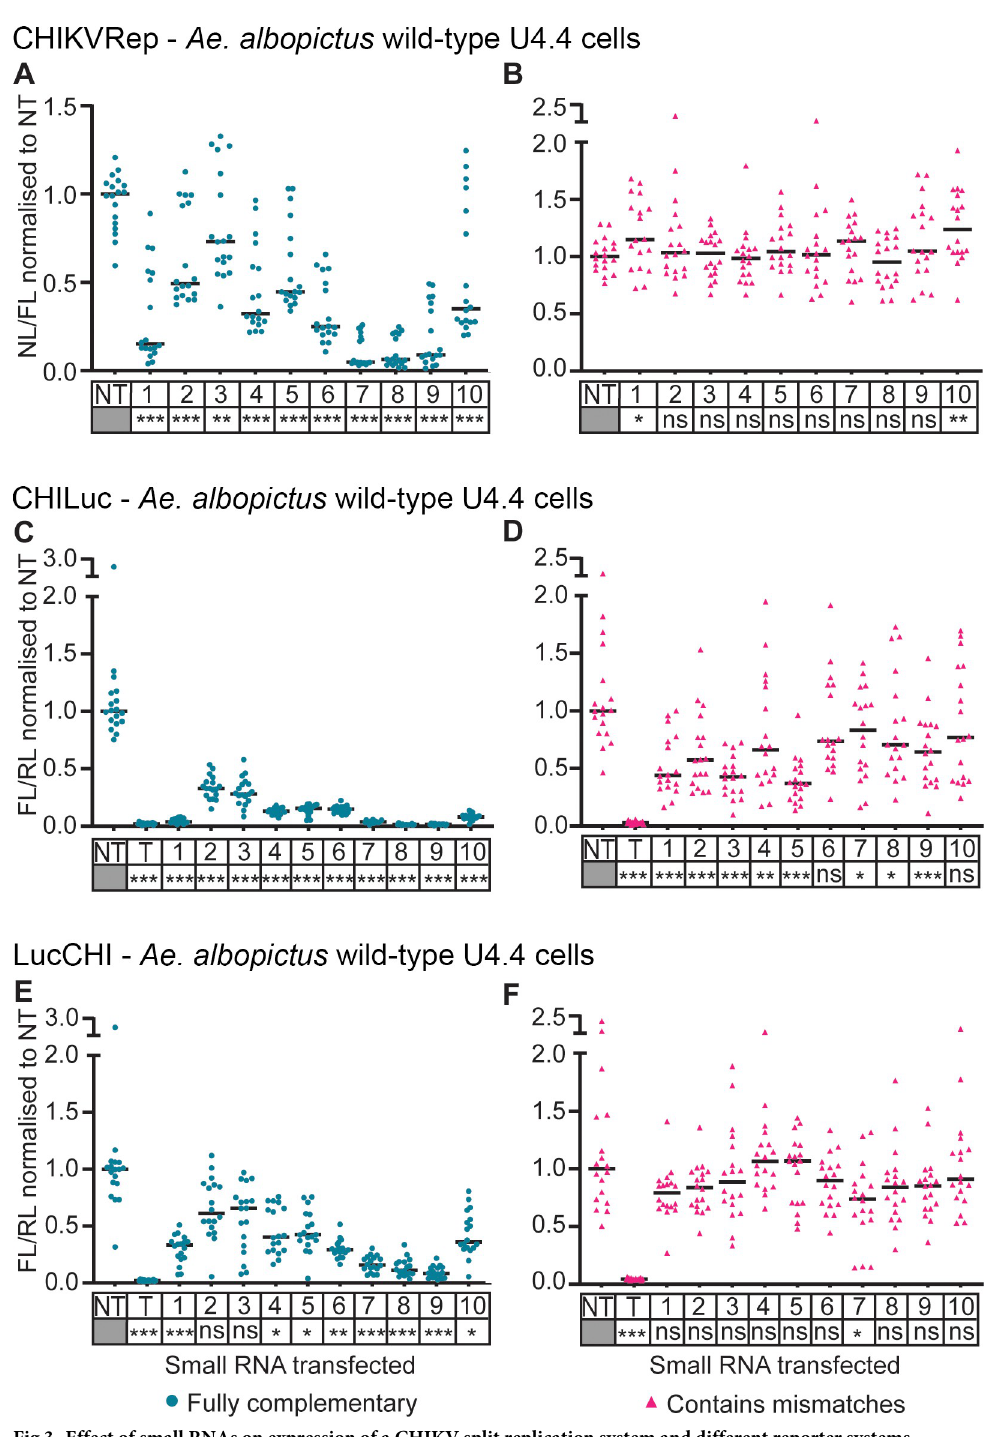
Fig 3. Effect of small RNAs on expression of a CHIKV split replication system and different reporter systems containing viral sequences in Ae . albopictus wild-type U4.4 cells. Plasmids expressing selected shRNA-like small RNAs (Fully complementary, blue) or miRNA-like small RNAs (Contains mismatches, pink) were co-transfected with a split replication system with nanoluciferase (NL) under the control of a CHIKV subgenomic promoter, and a plasmid expressing firefly luciferase (FL) as control for transfection efficiency ( A, B ), a chimeric CHILuc reporter containing the target sequence within the protein coding region ( C, D ), or a LucCHI reporter which has the target sequence in the 3’ UTR ( E, F ). A plasmid expressing Renilla luciferase (RL) as control for transfection efficiency was used in C-F, as well as